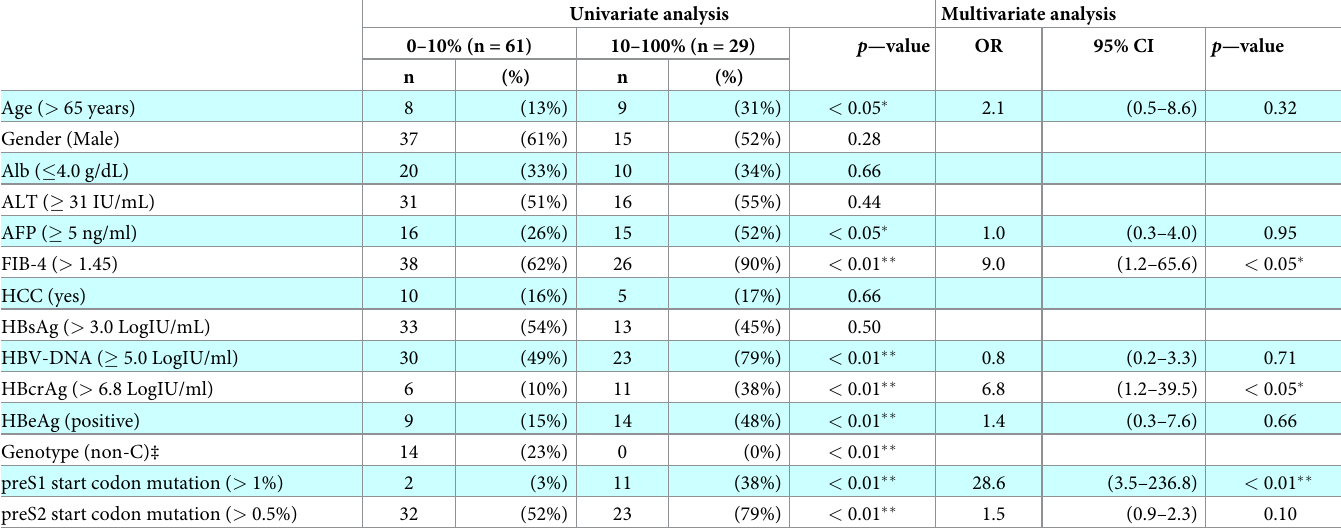
Table 2. Univariate and multivariate analysis for factors associated with preS codon 132–141 deletion ( �